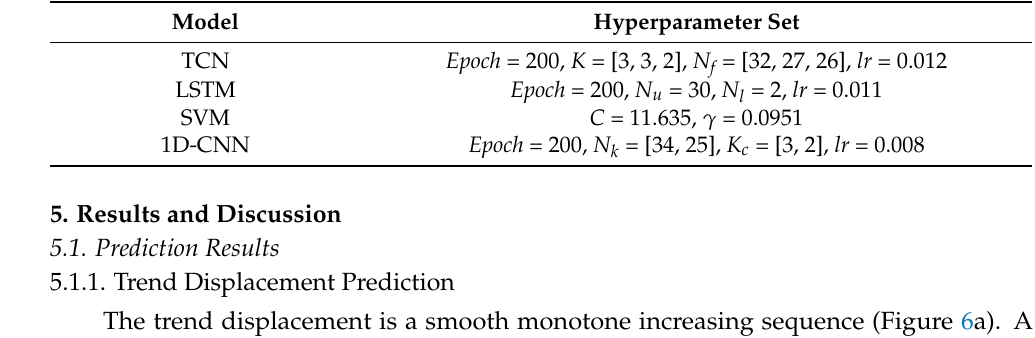
Table 1. The hyperparameters of TCN and the three comparison models. Model